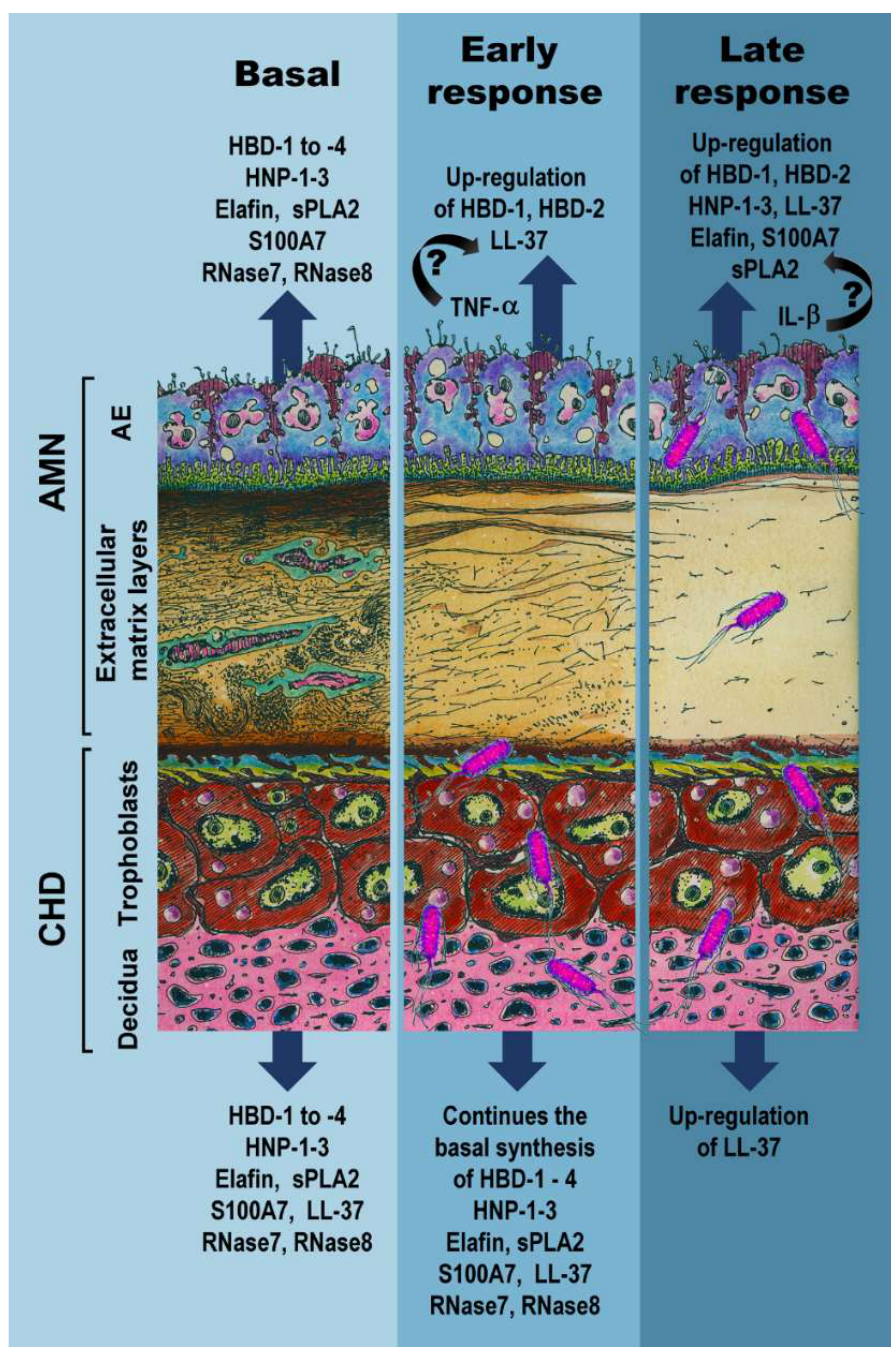
Figure 7. Schematic overview of AMP synthesis and the mechanical structure of chorioamniotic membranes in response to an Escherichia coli choriodecidual infection. In the basal state, the chorioamniotic membrane presents fully intact fibers of collagen. The AMN and CHD basally synthesize HBD-1 to -4, HNP-1-3, elafin, sPLA2, S100A7, RNAse-7, and RNAse-8, whereas LL-37 is absent in AMN. The challenge with a choriodecidual infection by E. coli disrupts the mechanical integrity of the collagen fibers and favors a TNF-α inflammatory milieu. The AMN side induces the early (2–4 h) synthesis of HBD-1, HBD-2, and LL-37 in response to E. coli . We hypothesize that TNF- α may drive the first AMP wave. At this time point, the CHD continues synthesizing all basally produced peptides. Bacteria bodies are observed only in the CHD compartment. In the late response (after 8 h of infection with E. coli ) , the extracellular matrix of the AMN was practically destroyed, and it appears to be an inflammatory environment enriched by IL-1β instead TNF-α. In this late wave after bacterial challenge, AMN synthesis of HBD-1, HBD-2, HNP-1-3, LL-37, S100A7, elafin, and sPLA2 are induced, whereas LL-37 is upregulated in the CHD compartment. IL-1β may control